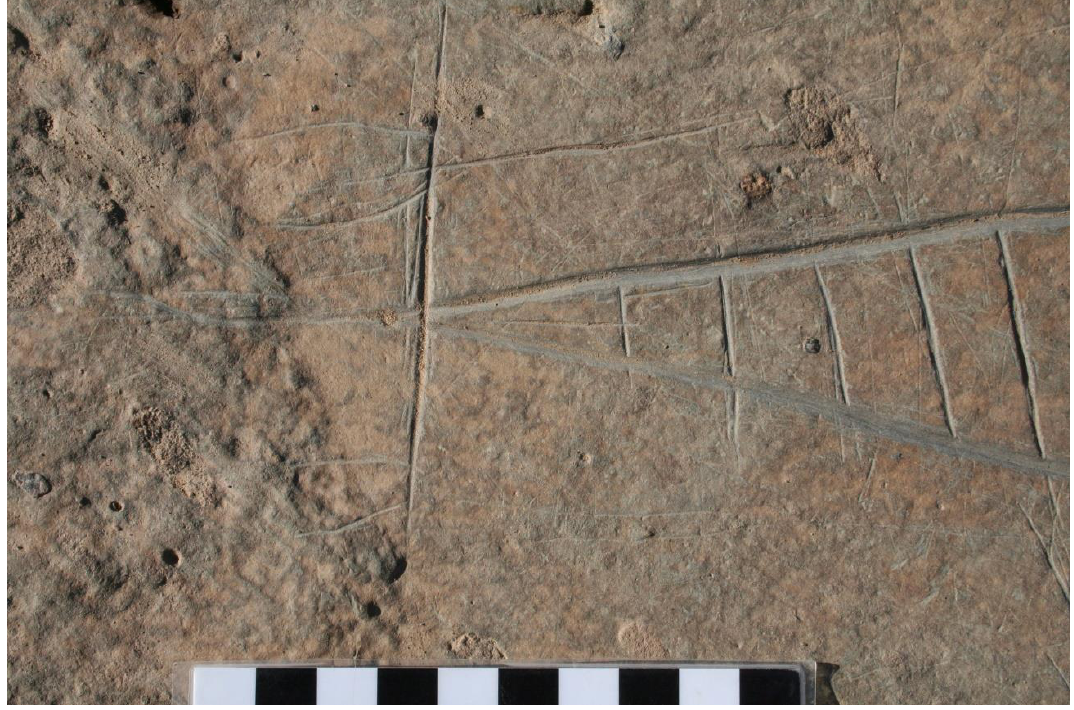
Figure 6. Detail of the draught animals in the chariot nº